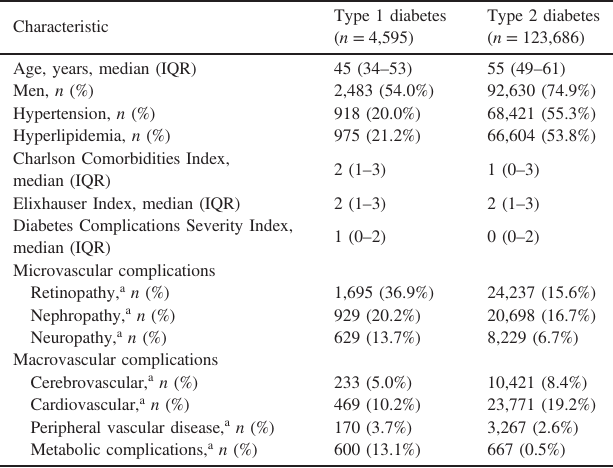
Table 1. Participant characteristics, according to diabetes type